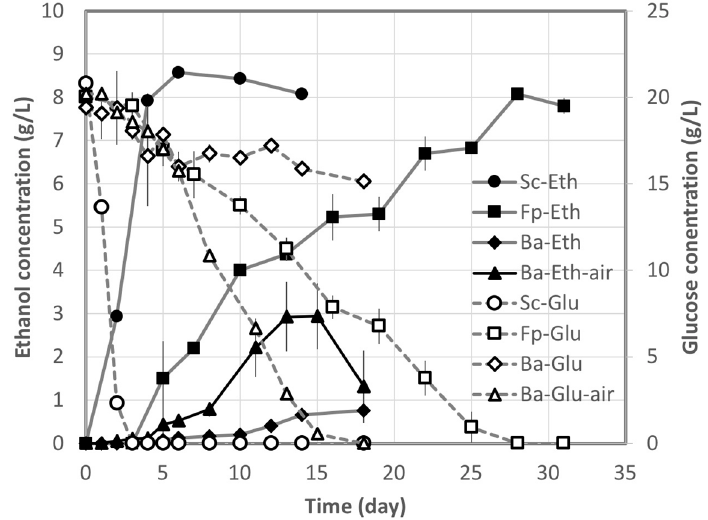
Figure 1. Ethanol (Eth) production from glucose (Glu) by Schizophyllum commune NBRC 4928, Bjerkandera adusta IWA5b, and Fomitopsis palustris NBRC 30339. Plots and bars show the average and standard deviation obtained from triplicate experiments.